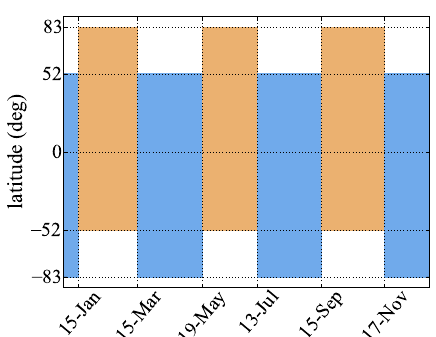
Figure 4. SABER latitude coverage during 2008; orange bands are coverages of northward viewing, while blue bands show coverages of southward viewing. For details, see text.